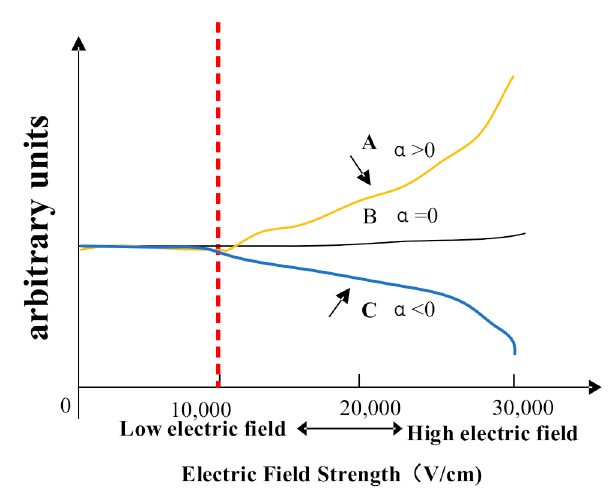
Figure 2. The variation curves of ion mobility at high and low electric fields [21].